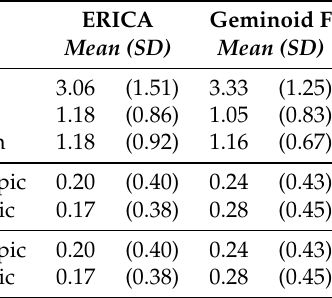
Table A1. Result of each